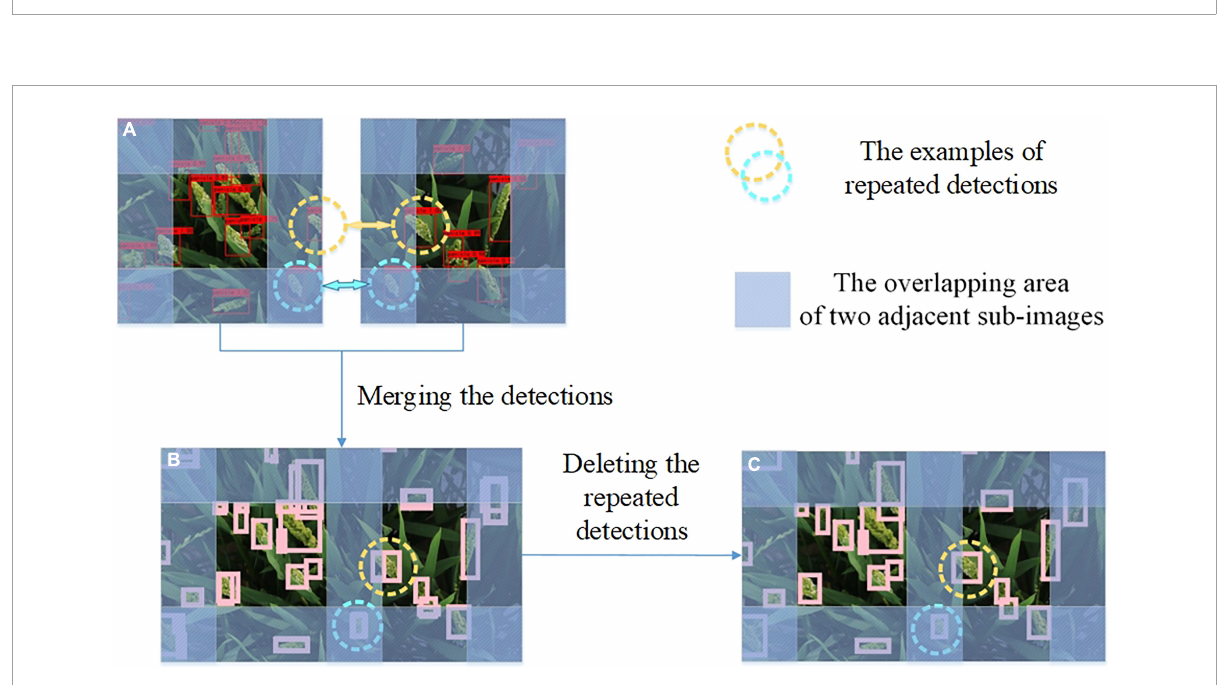
FIGURE4 The specific processing steps of deleting the repeated detections. (A) Repeated detections in the overlapping area of two adjacent sub-images. (B) Merging results directly. (C) Deleting the repeated detections in two adjacent